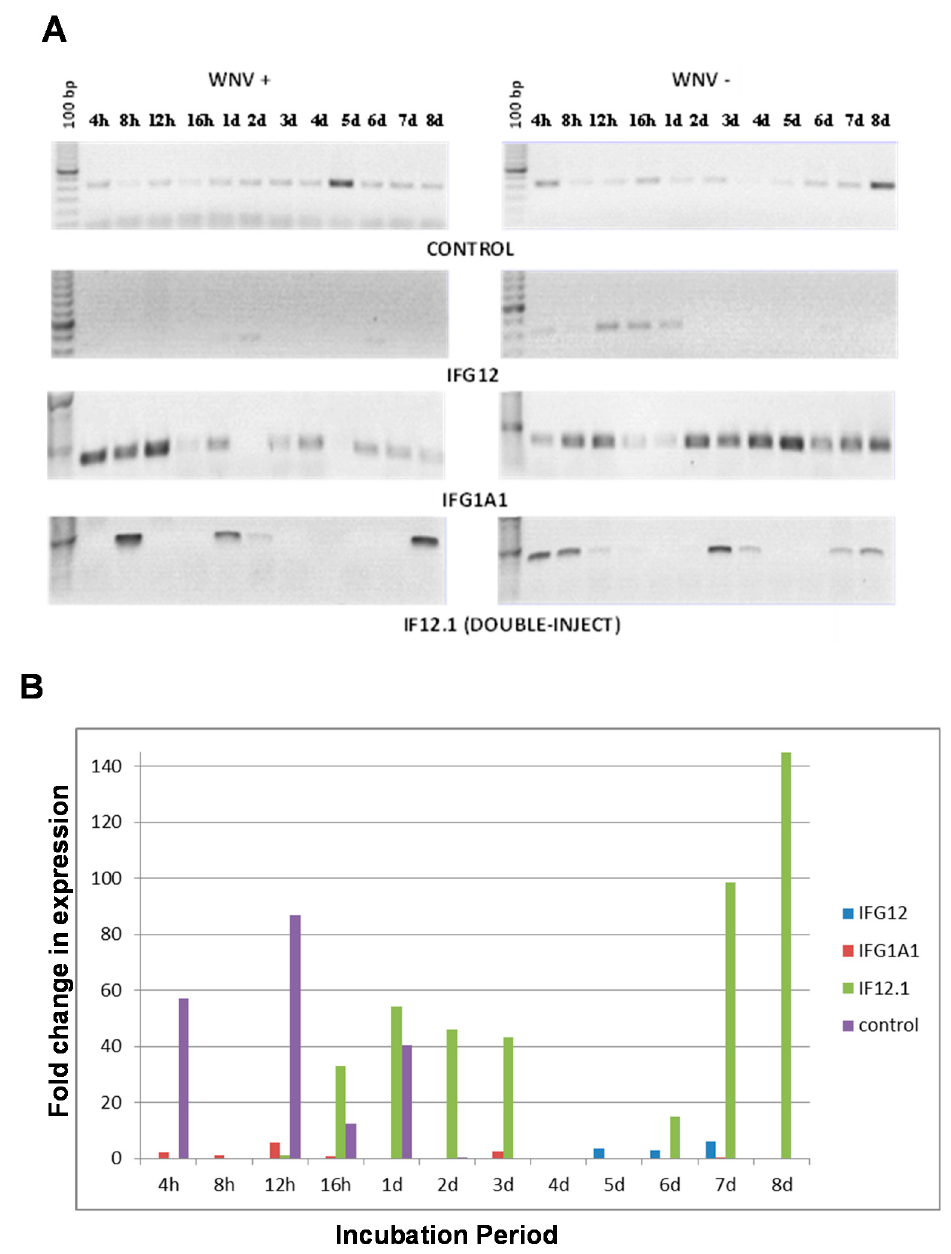
Figure 3. CQ G1A1 gene expression analysis in RNAi injected Cx. quinquefasciatus (CPQG) midguts dissected at different incubation periods post WNV infection. ( A ) RT-PCR analysis of CQ G1A1 expression; ( B ) qRT-PCR analysis of CQ G1A1 expression. 100 bp = DNA molecular weight marker; h, hours; d, days; Control, noninjected; IFG12, injected with CQ G12A2 RNAi; IFG1A1, injected with CQ G1A1 RNAi; IF12.1, injected with CQ G12A2 and CQ G1A1 RNAi. + = WNV in blood meal, − = no WNV in blood meal.